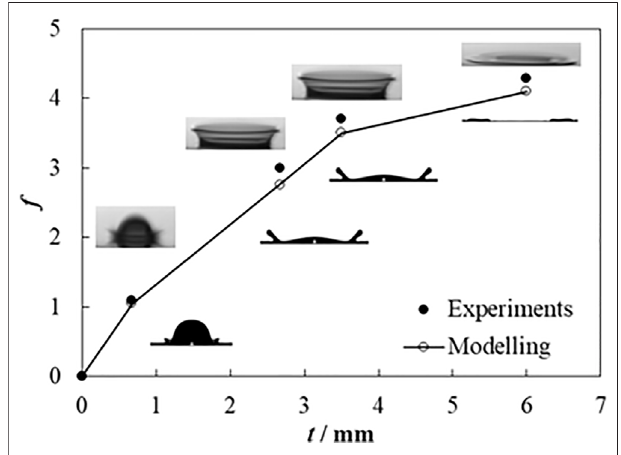
FIGURE 3 | Comparison of the experiment (Gulyaev and Solonenko, 2013) and simulation results for hollow droplet impact.